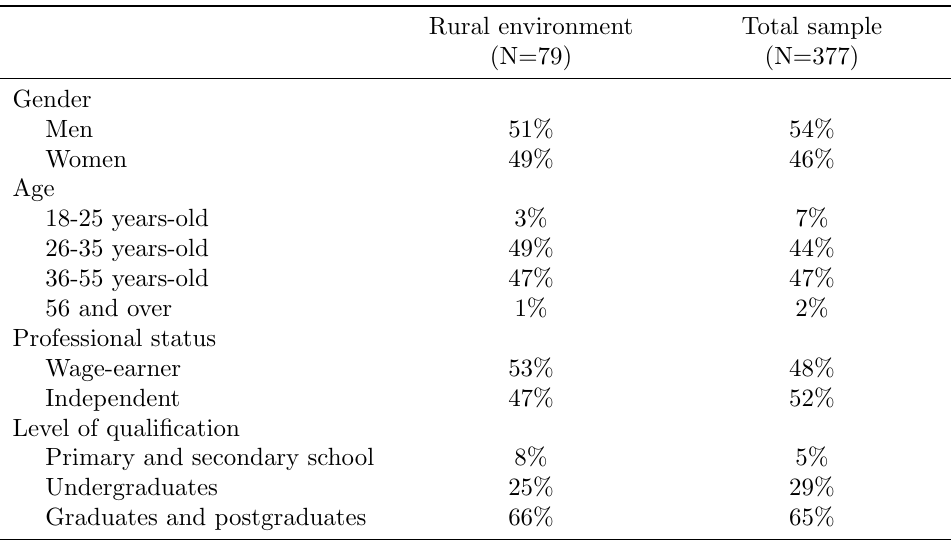
Table 5: Sociodemographics of coworkers Rural